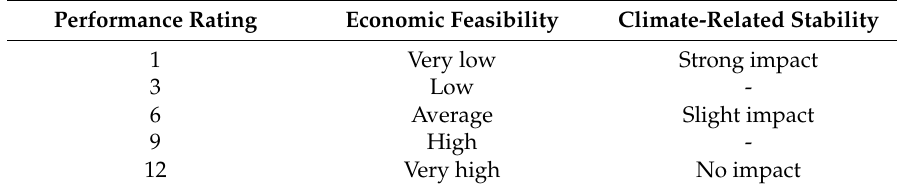
Table 4. Assignment of performance value for economic feasibility and climate change stability